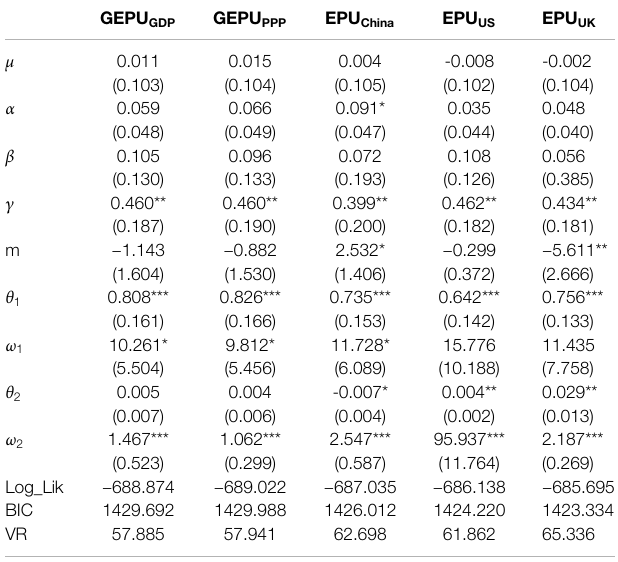
TABLE 3 | Estimation GARCH-MIDAS models with economic policy uncertainty.